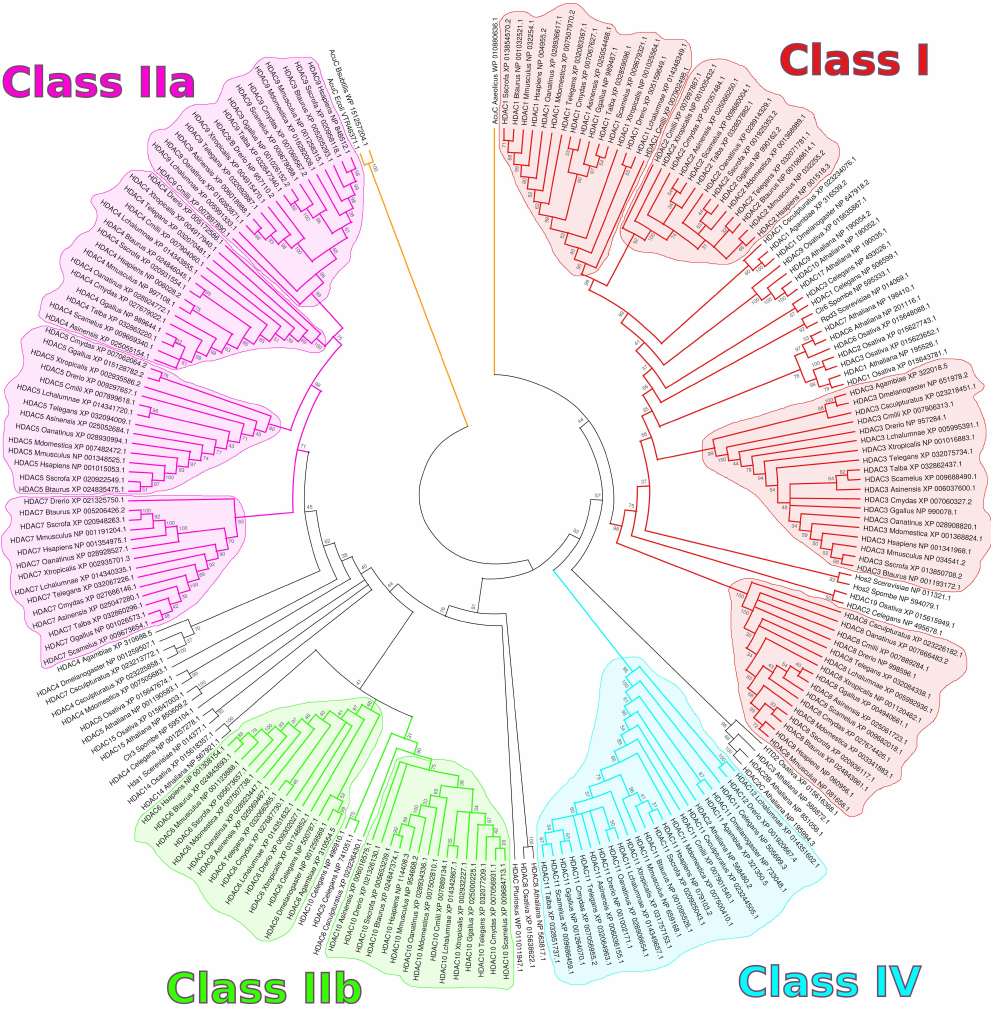
Figure 1. Topological phylogenetic tree representation of 226 representatives of the HDAC protein family. The longest RefSeq protein isoform was selected for each separate gene locus. Multiple sequence alignment was performed using the MUSCLE algorithm [32]. Evolutionary distances were computed as the number of amino acid substitutions per site using the Poisson correction method [33]. The implementation of these algorithms and the visualization were achieved through MEGA X [34]. All 226 sequences used for the generation of this figure are available as Supplementary File S2, in FASTA format. Coloring of branches indicate the putative HDAC class: red for Class I, magenta for Class IIa, green for Class IIb, and cyan for Class IV. Colored areas delimit clades associated to each one of the 11 human